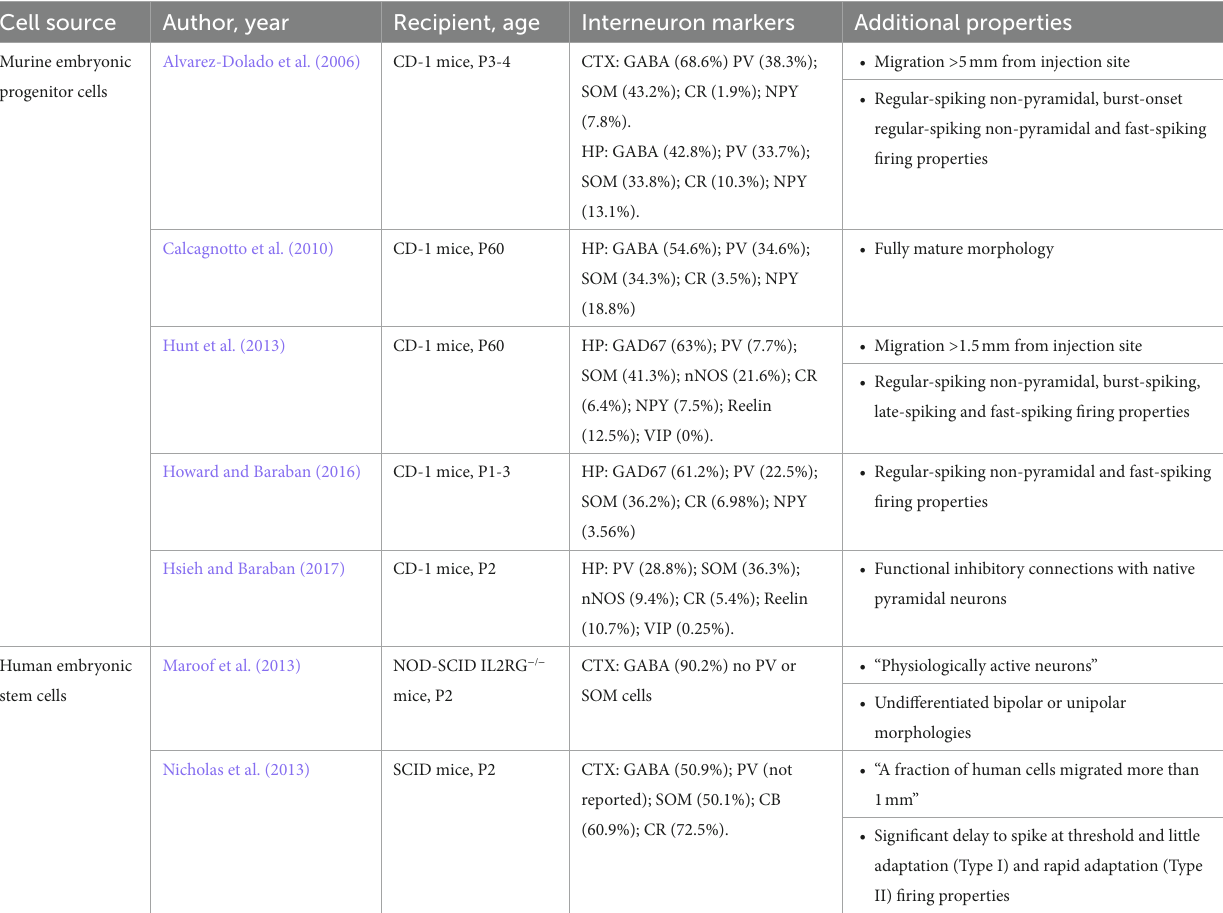
TABLE 1 Medial ganglionic